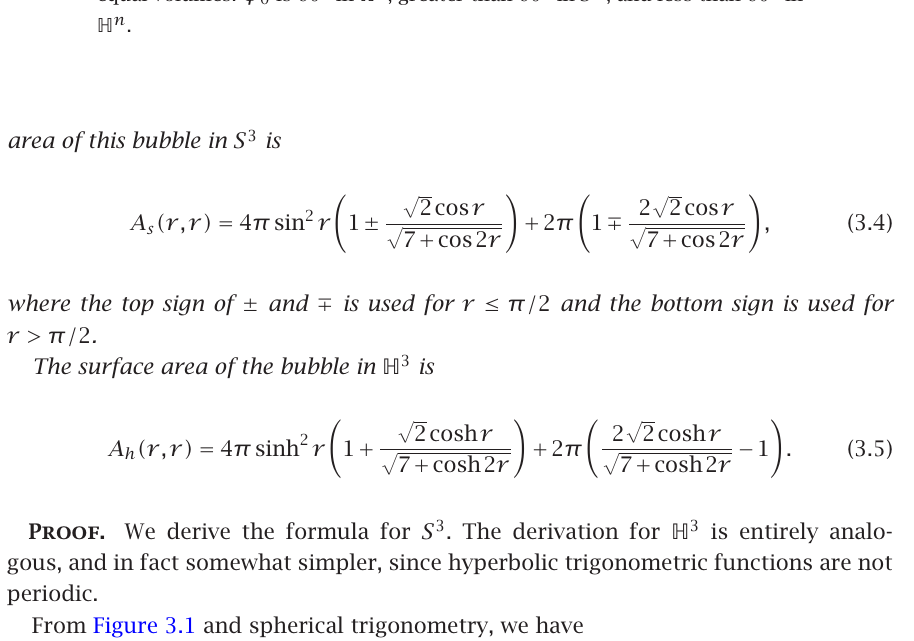
Figure 3.1 . Generating curve for a standard double bubble enclosing two equal volumes. ϕ 0 is 60 ◦ in R n , greater than 60 ◦ in S n , and less than 60 ◦ in H n